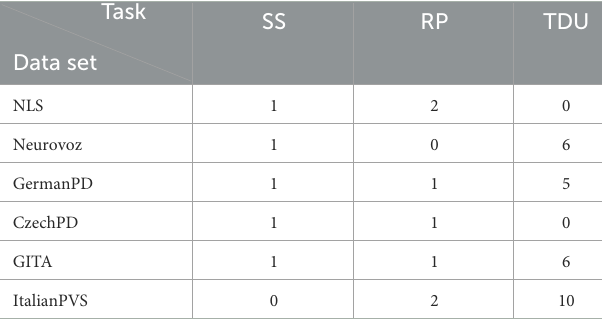
TABLE 1 Typologies of tasks analyzed with the corresponding number (#) of samples available in each data set.